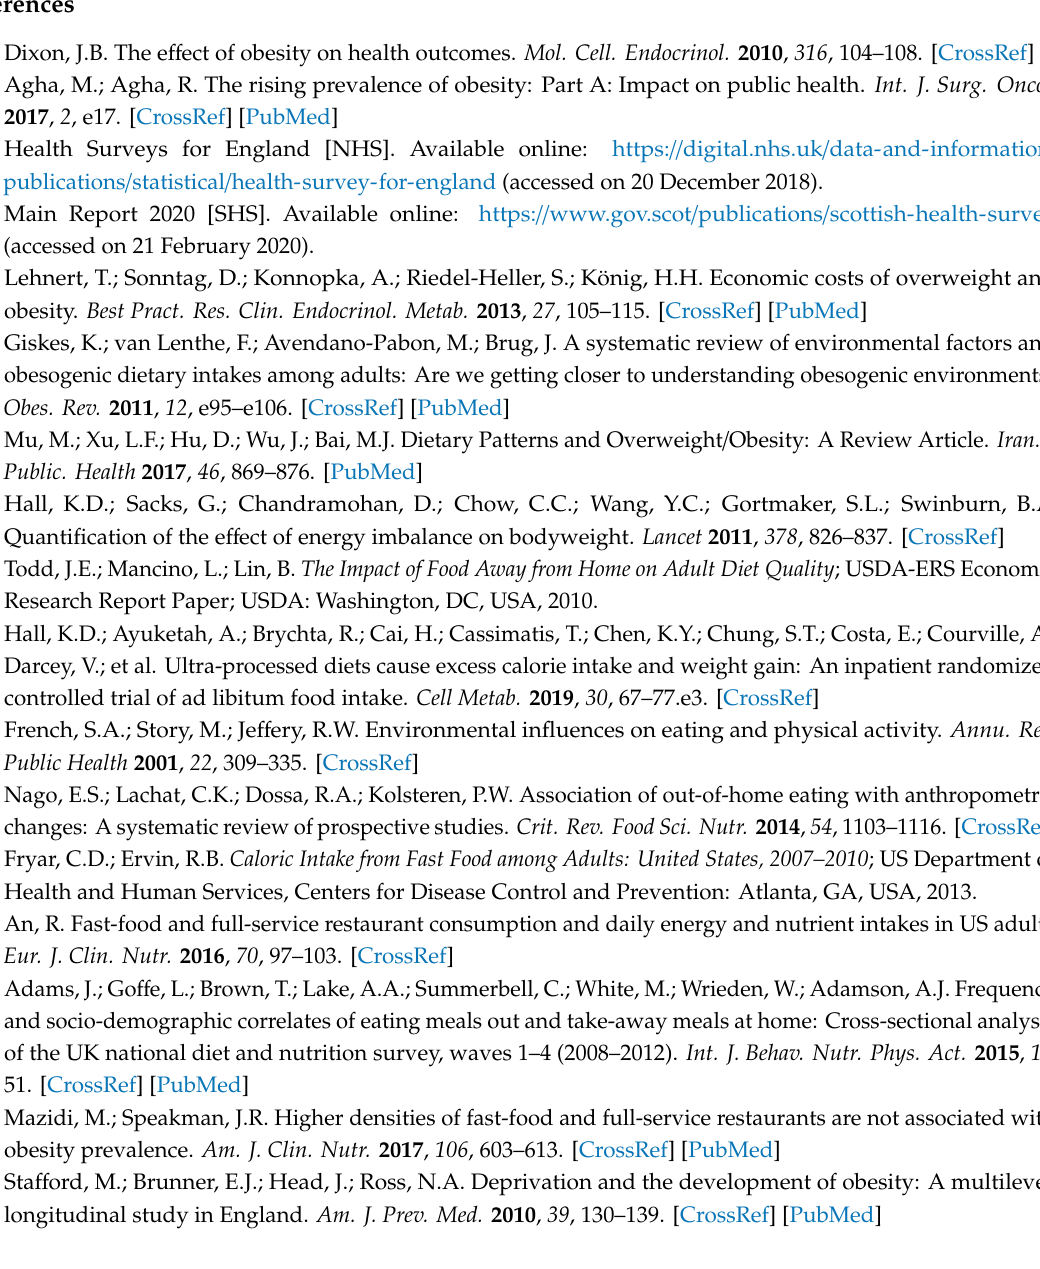
BMI vs the frequency of food outlet usage for 7-consecutive days segregated by sex, Table S4: ANOVA analysis: Adjusted mean